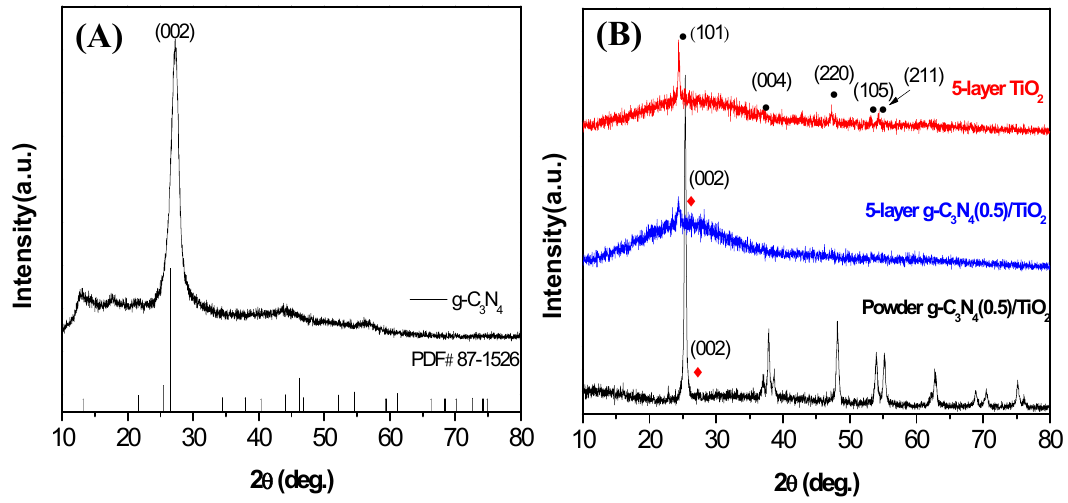
Figure 1. X-ray diffraction (XRD) patterns of ( A ) g-C 3 N 4 and ( B ) 5-layer TiO 2 , 5-layer Figure 1. X-ray di ff raction (XRD) patterns of ( A ) g-C 3 N 4 and ( B ) 5-layer TiO 2 , 5-layer g-C 3 N 4 (0.5) / TiO 2 , g-C 3 N 4 (0.5)/TiO 2 , powder g-C 3 N 4 (0.5)/TiO 2 . powder g-C 3 N 4 (0.5) / TiO 2